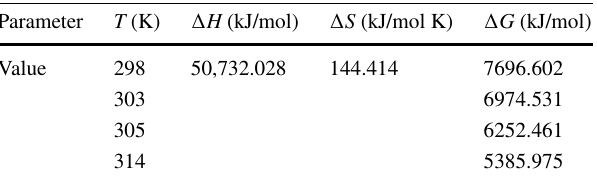
Table 8 The chemical thermodynamic parameters for the sorption of CR on Aspergillus niger